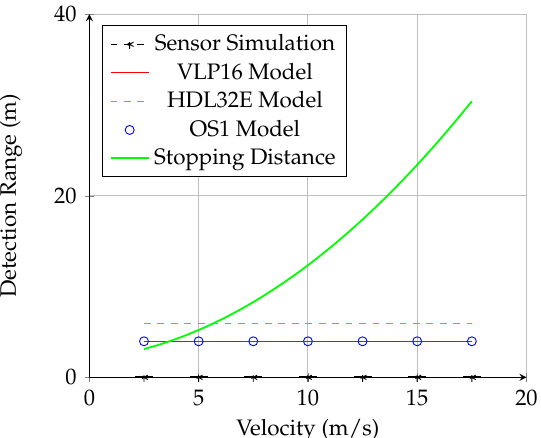
Figure 6. Results for the UGV-mounted sensors. The red line is the analytical model, the black line is the simulation, and the green line is the stopping distance.The dashed black line and marks are the result of the physics-based simulation. The detection range was uniformly 0 for all cases, meaning the algorithm was unable to detect the negative obstacle in any case in the simulation for the UGV-mounted sensor.